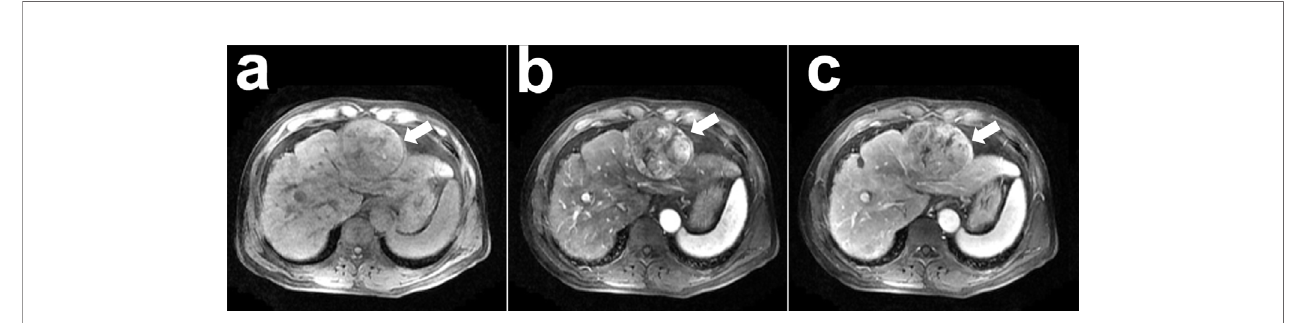
FIGURE 5 | A case of hepatocellular carcinoma (HCC) with contrast-enhanced MR: a 51-year-old man with pathological con fi rmed HCC (white arrow) and microvascular invasion (MVI) present. This neoplasm was misdiagnosed as the absence of MVI by the 3D CNN model with pre-contrast phase (A) , arterial phase (B) , portal vein phase (C) images and concatenation (CON), while the proposed 3D convolutional neural networks (CNN) with deep supervision net (DSN) model made correct diagnose as the present